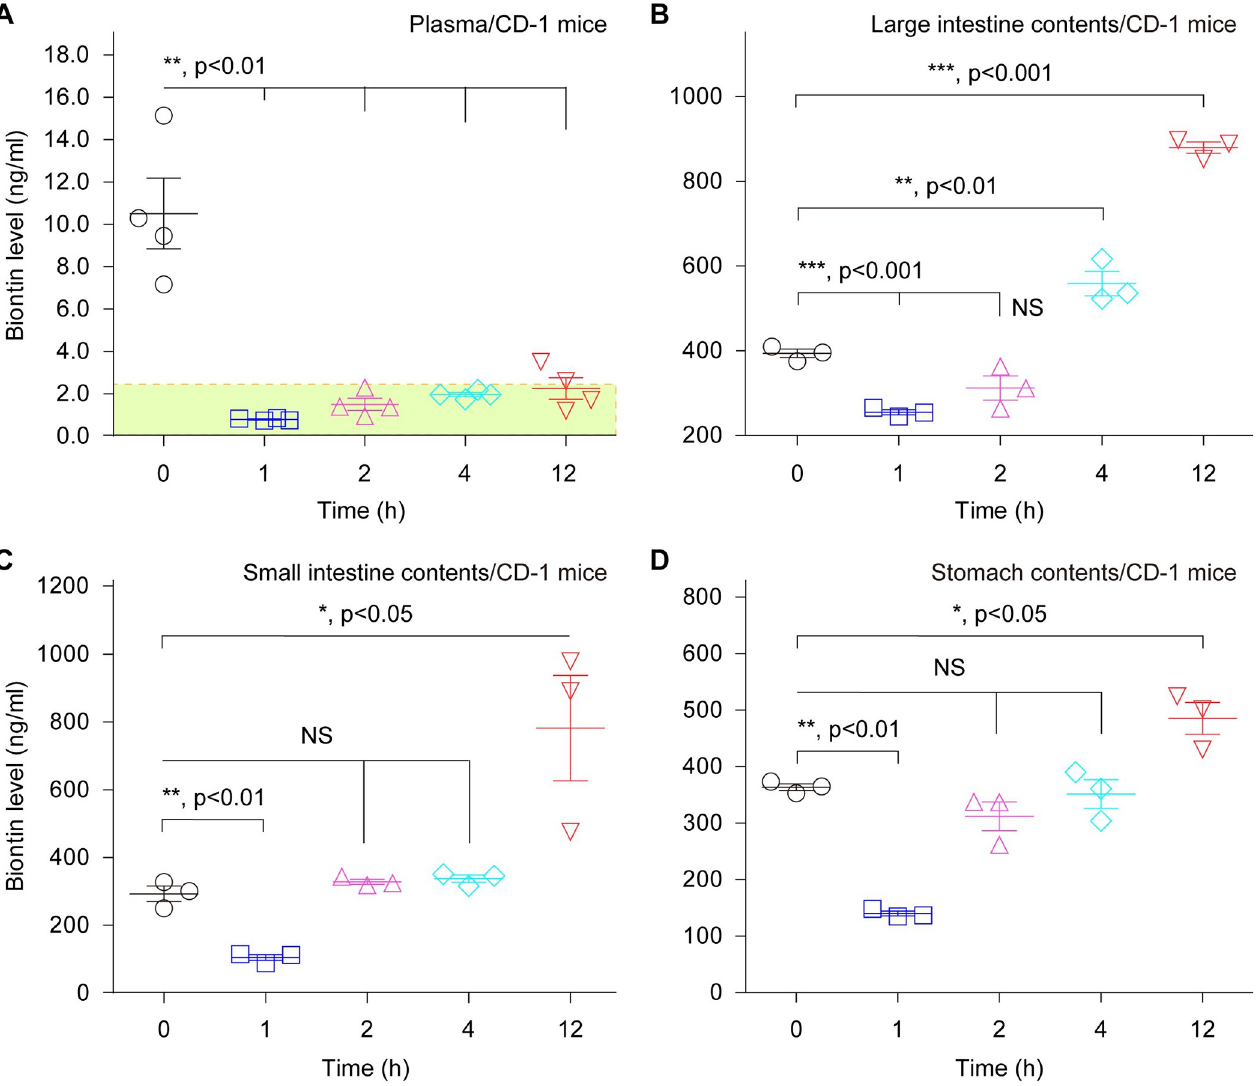
Fig 7. Intraperitoneal administration with streptavidin benefits an establishment of a CD-1 mice model for P . aeruginosa , of which the plasma (and organ contents) biotin levels are dramatically decreased at an initial infection stage. A. Intraperitoneal administration of CD-1 mice with streptavidin renders its plasma biotin decreased at the comparable level with human plasmas. The range of human plasma biotin level (1.38 to 2.38 ng/ml) is indicated with a rectangle shadowed green. The biotin levels in large intestine contents ( B ), small intestine contents ( C ), and stomach contents ( D ), are reduced significantly at 1-hour post-intraperitoneal administration with streptavidin. To mimic human infection with P . aeruginosa , the model of CD-1 mice is subjected for an intraperitoneal administration with streptavidin (2 mg/kg) as recently Carfrae et al . [15] recommended, which is supposed to reduce the biotin levels in mouse plasma and other organ contents. All the data are given in means ± SD, and assayed by two-tailed analysis of variance.